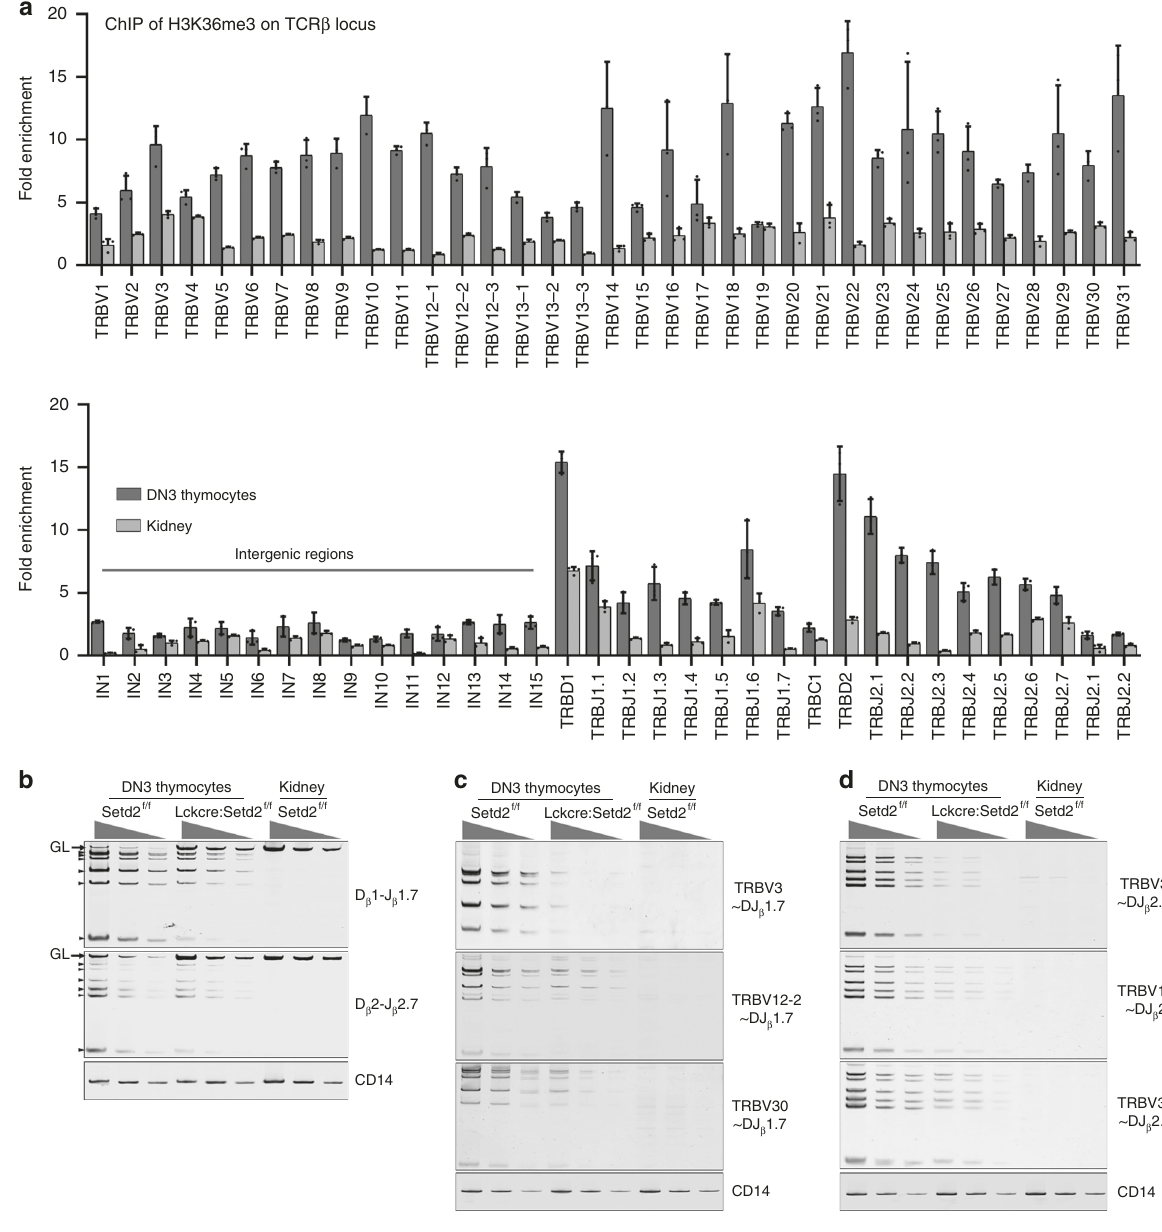
Fig. 5 Ablation of Setd2 impairs V(D)J rearrangement at TCR β gene loci. a ChIP analysis of H3K36me3 at TCR β gene loci in DN3 thymocytes. Mouse kidney was used as the negative control. Fold enrichments are normalized to input DNA. b Semi-quantitative PCR analysis of the indicated D β -to-J β segment rearrangements in sorted DN3 thymocytes from Lck-Cre + ;Setd2 f/f and control mice. c , d Semi-quantitative PCR analysis of the indicated c V β -to- DJ β 1.7 and d V β -to-DJ β 2.7 rearrangements in sorted DN3 thymocytes from Lck-Cre + ;Setd2 f/f and control mice. TRBV3 represents the distal V β segment, while TRBV12-2 and TRBV30 were selected to represent the middle and proximal V β segments, respectively. (For ( b – d ), mouse kidney was used as the negative control. GL: germline, black arrows: D β 2/J β 2.1-to-D β 2/J β 2.6 rearrangement. CD14 was used as the loading control. DNA was diluted to 3 concentrations ranging from 90 ng to 10 ng and subjected to 31 ampli fi cation cycles for V(D)J or D – J joint ampli fi cation or 25 cycles for CD14 ampli fi cation, Source data are provided as a Source Data fi le) We further crossed Setd2 f/f mice with Cd19-Cre transgenic pro-B stage (Supplementary Fig. 6b). V(D)J recombination of Igh mice to achieve speci fi c knockout of Setd2 in the B cell lineage. in pro-B cells from Cd19-Cre + ; Setd2 f/f mice was impaired upon Setd2 deletion (Supplementary Fig. 6c). Collectively, these H3K36me3 modi fi cation was signi fi cantly reduced in sorted fi ndings indicate that Setd2 is required for V(D)J rearrangement B220 + CD19 + B cells from Cd19-Cre + ;Setd2 f/f mice compared with that in control mice (Supplementary Fig. 6a), suggesting of Igh and for B cell development. ef fi cient Setd2 deletion in B cells of Cd19-Cre + ;Setd2 f/f mice. We analyzed B cell development in Cd19-Cre + ;Setd2 f/f and control Setd2 de fi ciency reduces Rag1-RSS binding and DNA repair . mice by fl ow cytometry. Consistent with our observations in To understand the molecular mechanism underlying the V(D)J Mx1-Cre + ;Setd2 f/f mice, B cell development was blocked at the recombination defects induced by Setd2 loss, we fi rst examined NATURE COMMUNICATIONS| (2019) 10:3353